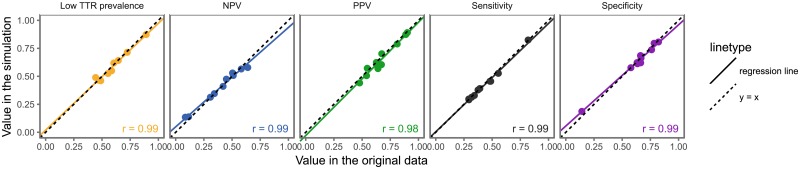
Calibration plot comparing simulated values with the corresponding values from the original studies.